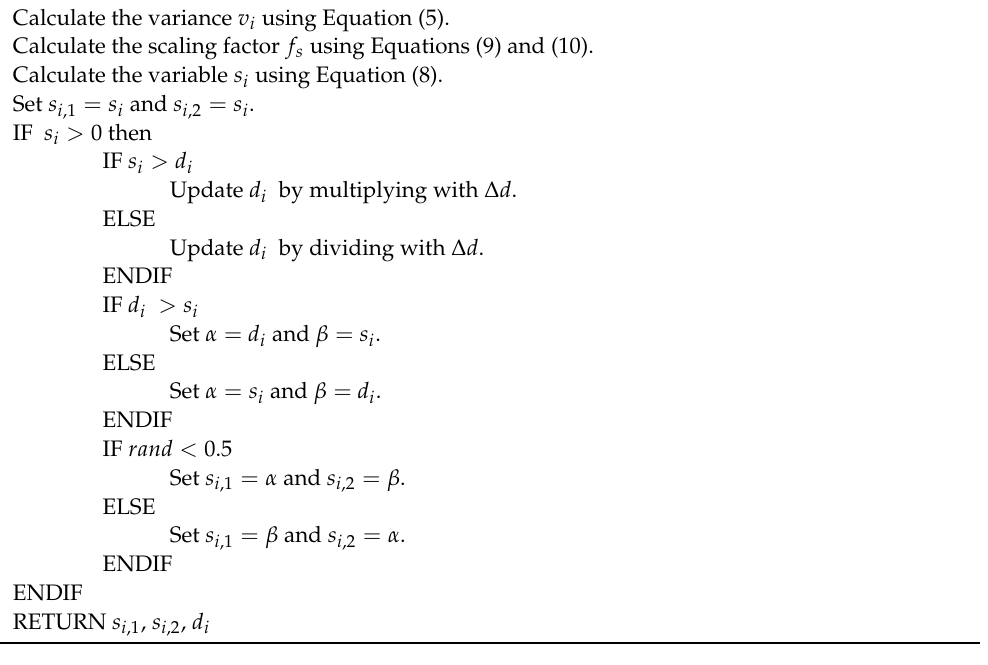
Algorithm 5 Calculating the shape variables s i ,1 and s i ,2 for dimension i at iteration j